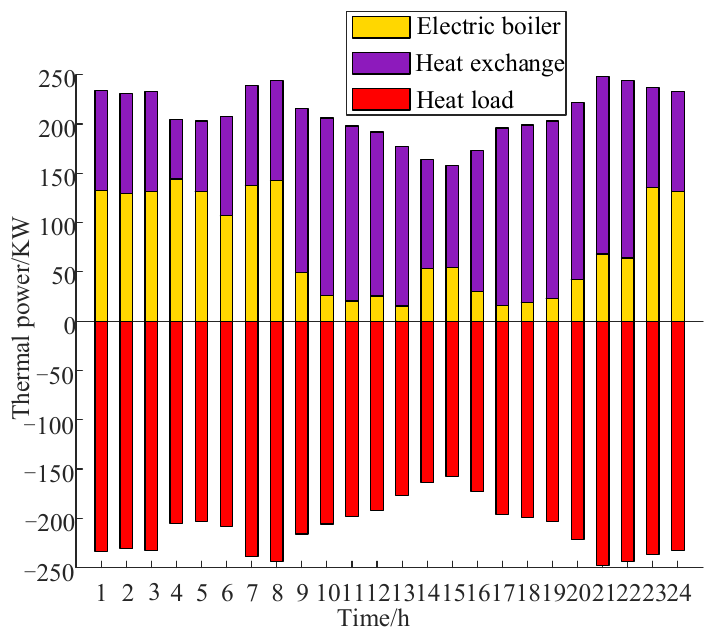
Figure 4. Thermal power optimization diagram.